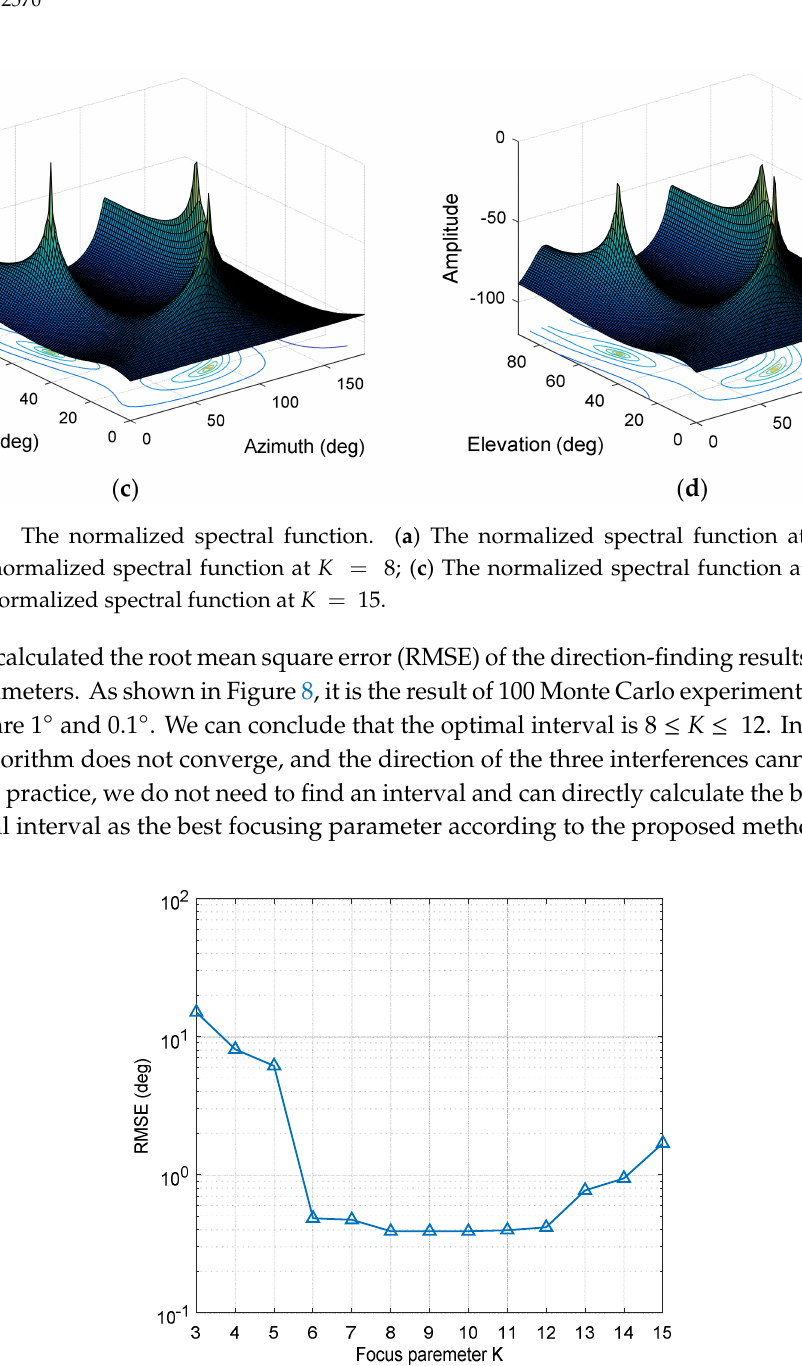
Figure 8. The direction-finding RMSE of STC-MUSIC algorithm with different focusing parameters.